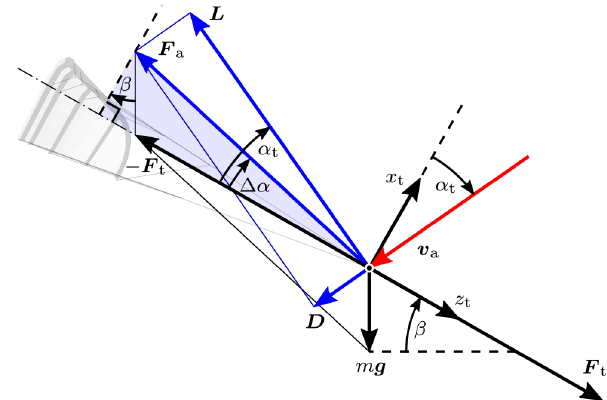
Figure 10. Force equilibrium of a kite in steady-state flight for the special case of the kite oriented upwards with ψ = 0 ◦ , flying in the plane spanned by the wind velocity vector and the vertical, described by φ = 0 ◦ . The forces acting on the kite components are lumped to the bridle point. See Schmehl et al. (2013, Fig. 2.11) for an illustration of the force equilibrium extended to the general case of kite flight in three